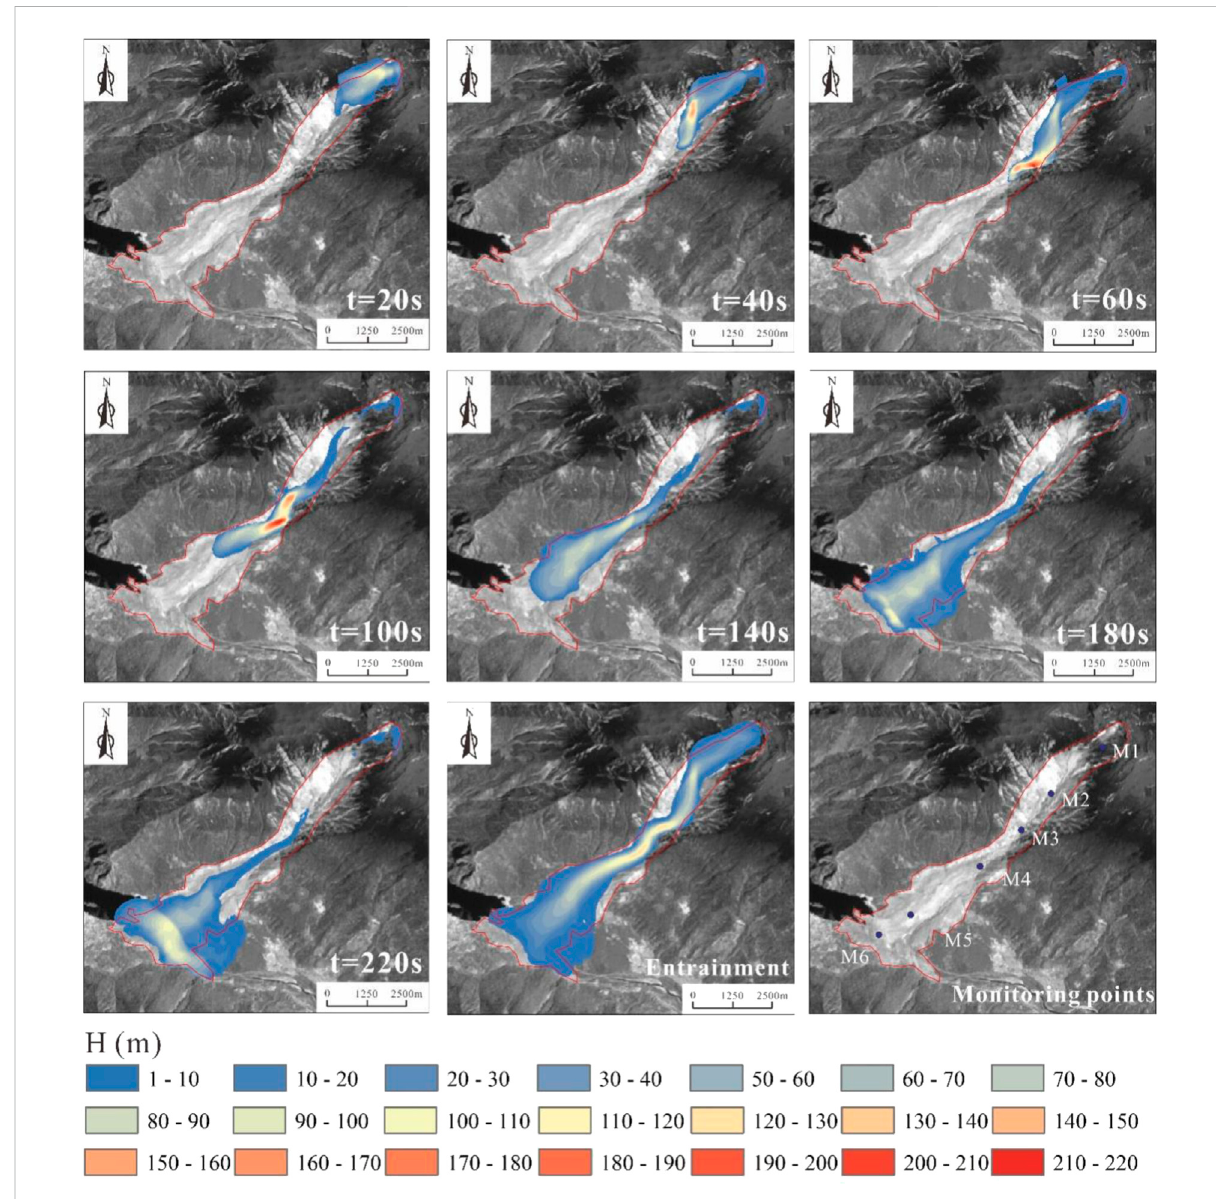
FIGURE 5 Simulation of motion process of the Yigong landslide in 2000 (The DEM used for the simulation is derived from NASA; https://earthdata.nasa. gov/).